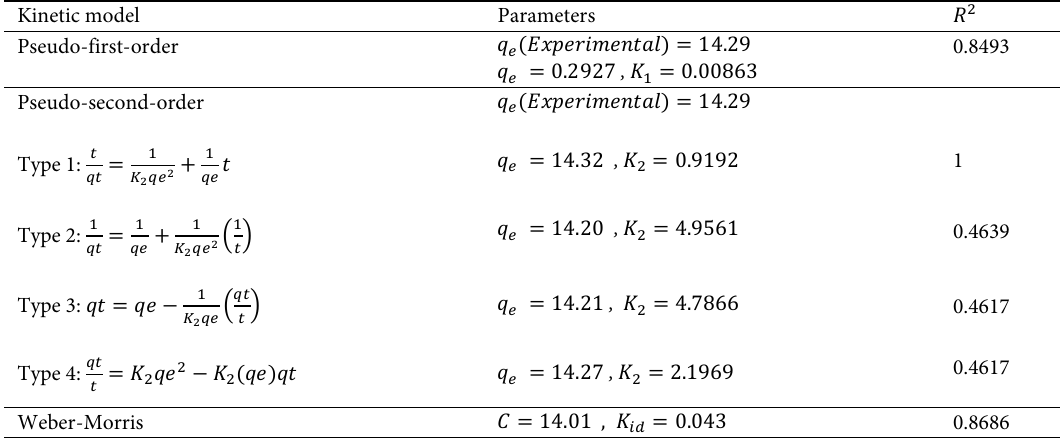
Table 1 Kinetic constants for Amido Black 10B dye adsorption. Table 1. Kinetic constants for Amido Black 10B dye adsorption